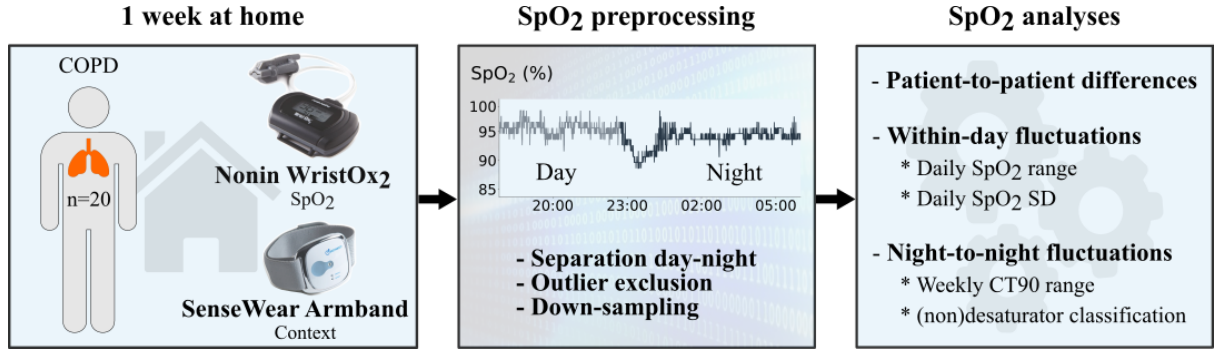
Figure 1. General overview of the applied methods. COPD: chronic obstructive pulmonary disease; SpO 2 : peripheral blood oxygen saturation; CT90: cumulative time spent with SpO 2 below